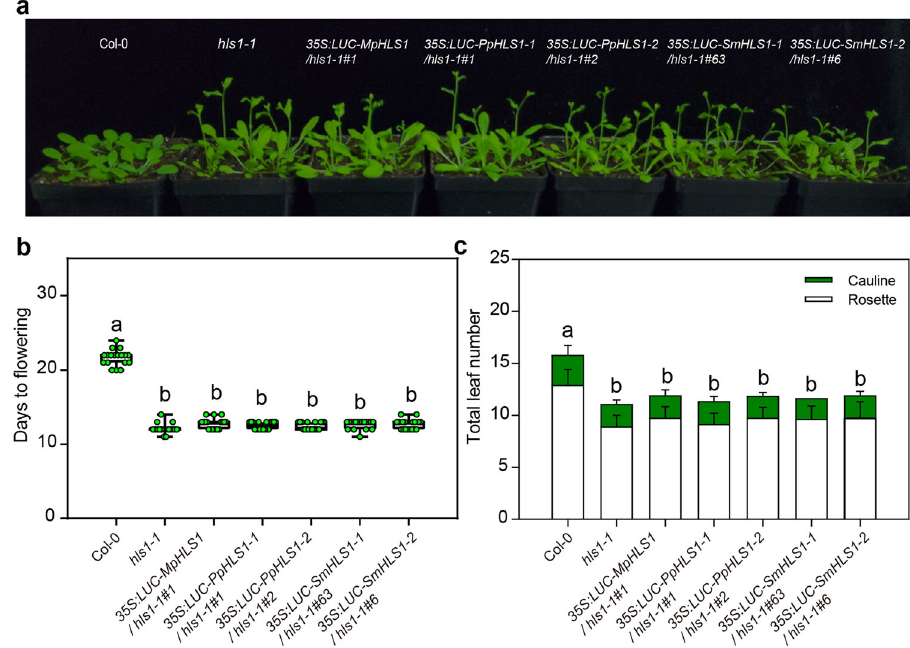
Fig. 7 Flowering phenotypes under long-day conditions. a Images show representative fl owering phenotypes of 16-day-old plants grown under LD conditions. b Statistical analysis of the days from germination to fl owering under LD conditions. Signi fi cant differences were determined by one-way analysis of variance (ANOVA) and post hoc Tukey ’ s test, with different lowercase letters indicating signi fi cant differences (data are means± SD; n = 18, P < 0.05). c Statistical analysis of the total leaf number under LD conditions. Signi fi cant differences were determined by two-way analysis of variance (ANOVA) and post hoc Tukey ’ s test, with different lowercase letters indicating signi fi cant differences (data are means ± SD; n = 18, P <